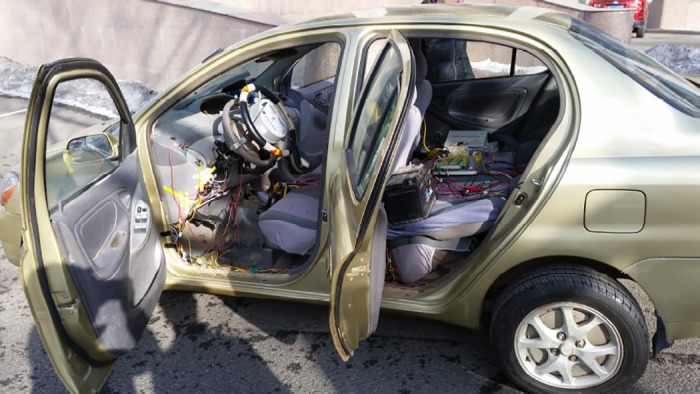
The tested vehicle.